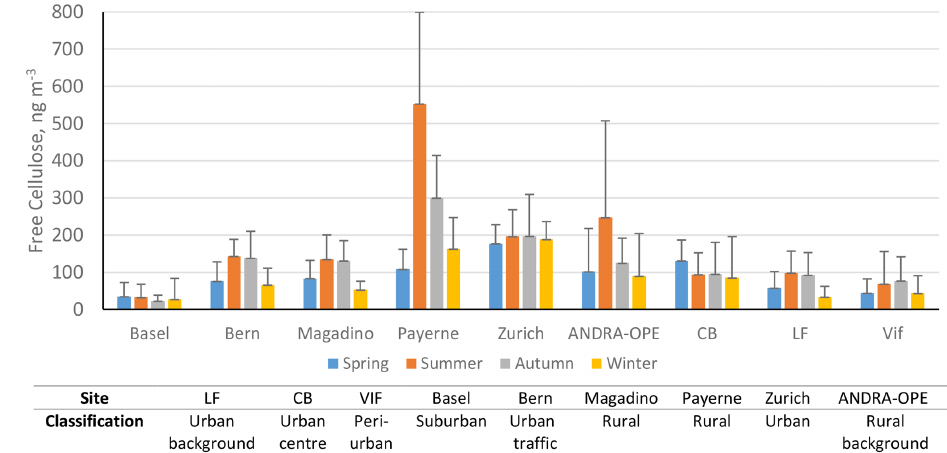
Figure 4. Mean cellulose concentrations (ngm − 3 ) at each site, by season: spring (blue), summer (orange), autumn (grey), and winter (yellow). Black error bars represent 1 standard deviation of the seasonal averages. Only positive error bars are added, for clarity. LF: Les Frênes, CB: Caserne de Bonne. Grenoble-based sites represented by CB, LF, and Vif.